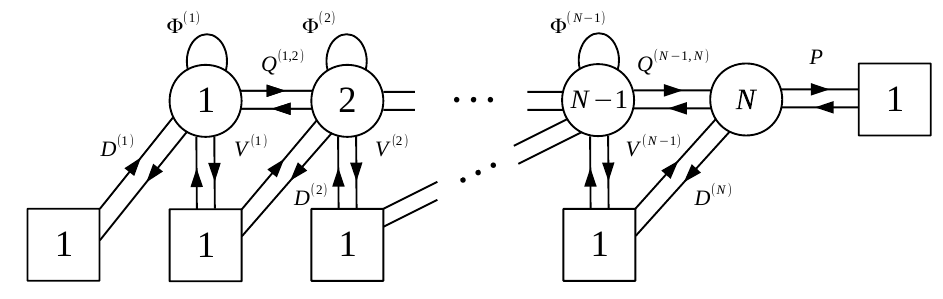
Figure 3 . Quiver diagram of the G [U( N )]